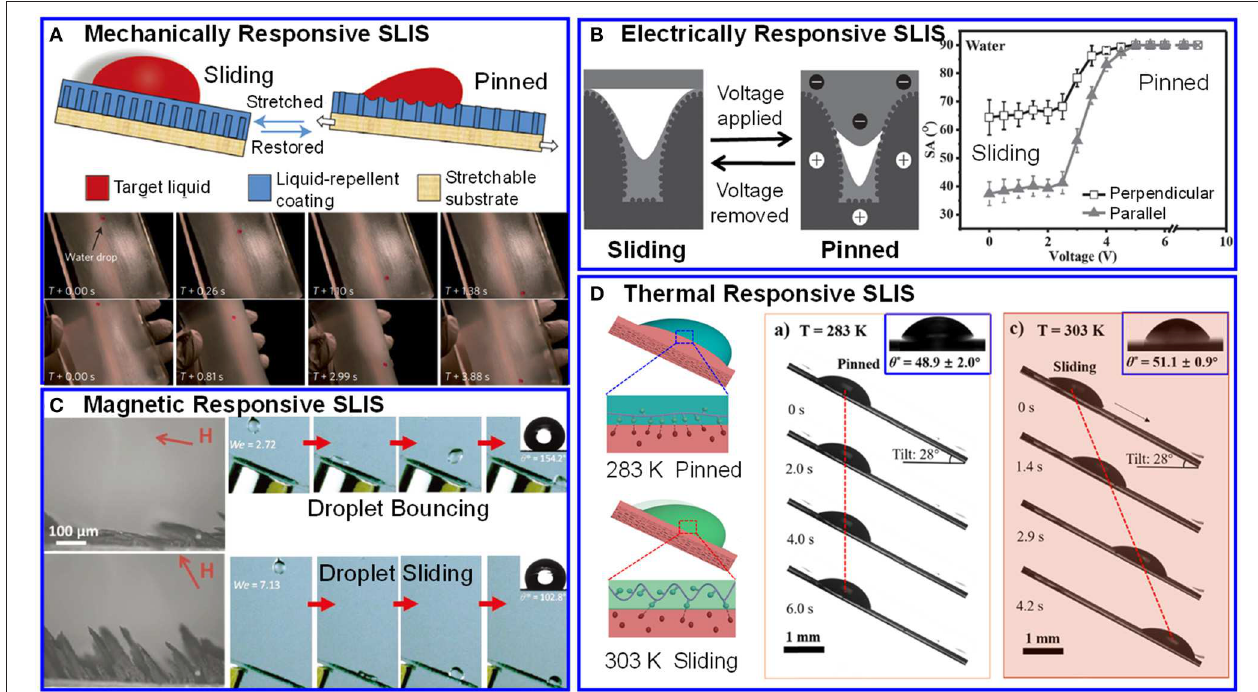
FIGURE 2 | Responsive SLIS display different wetting behaviors by different stimulus triggered. (A) Stress responsive SLIS (Yao et al., 2013), Reproduced with permission. Copyright 2013, Springer Nature. (B) Electric field responsive SLIS (Guo et al., 2016), Reproduced with permission. Copyright 2016, WILEY-VCH Verlag GmbH & Co. KGaA. (C) Magnetic field responsive SLIS ( Huang et al., 2017), Copyright 2017, WILEY-VCH Verlag GmbH & Co. KGaA. (D) Temperature responsive SLIS ( Wang et al., 2019). Copyright 2019,